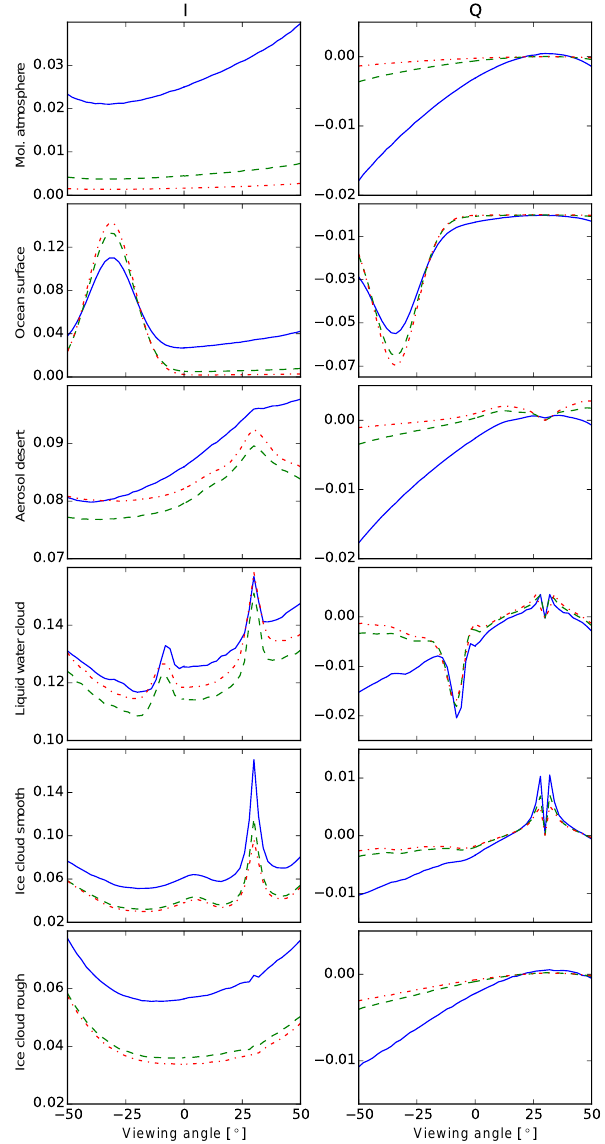
Figure 10. Stokes vector components I and Q at wavelengths of 443nm (blue solid lines), 670nm (green dashed lines), and 865nm (red dashed-dotted lines) for various atmospheric setups (see text for details). The radiances are calculated at the top of the atmo- sphere for viewing angles from − 50 to 50 ◦ , where 0 ◦ corresponds to the nadir